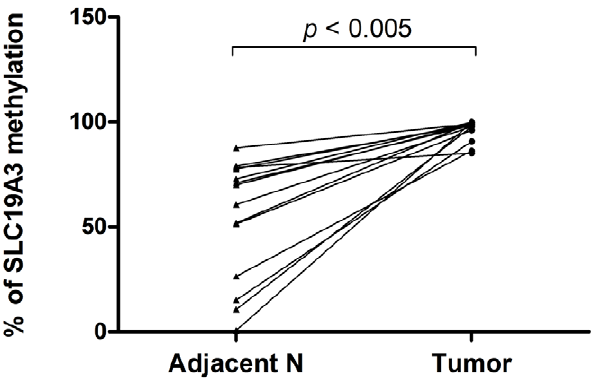
Figure 2. Increased percentage of SLC19A3 DNA methylation in primary breast cancer tissues. Percentage of SLC19A3 promoter methylation between tumor tissues and their paired adjacent non- tumor breast tissues from the 15 breast cancer patients by MS-qPCR. Percentage of methylation in tissue samples was calculated by the following equation: % meth=100/[1 + 2 D Ct(meth-unmeth) ]%. D Ct (meth-un- meth) was calculated by subtracting the Ct values of methylated SLC19A3 signal from the Ct values of umnethylated SLC19A3 signal. Statistical difference was analyzed by Wilcoxon test, P , 0.005.